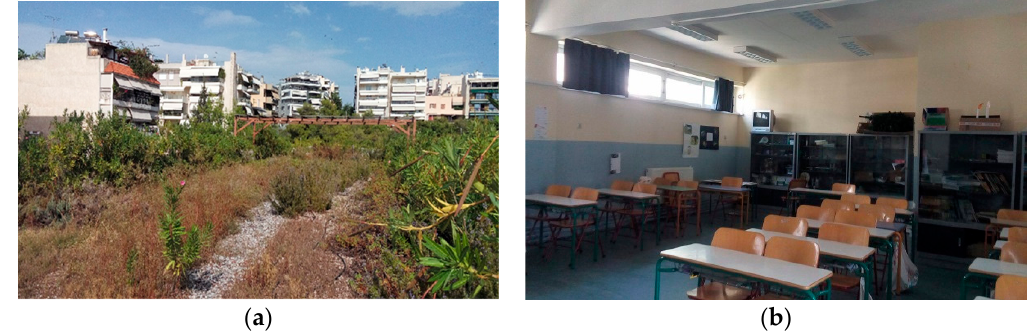
Figure 1. Experimental sites of the school: ( a ) the green roof system (GRS) and ( b ) classroom C3.